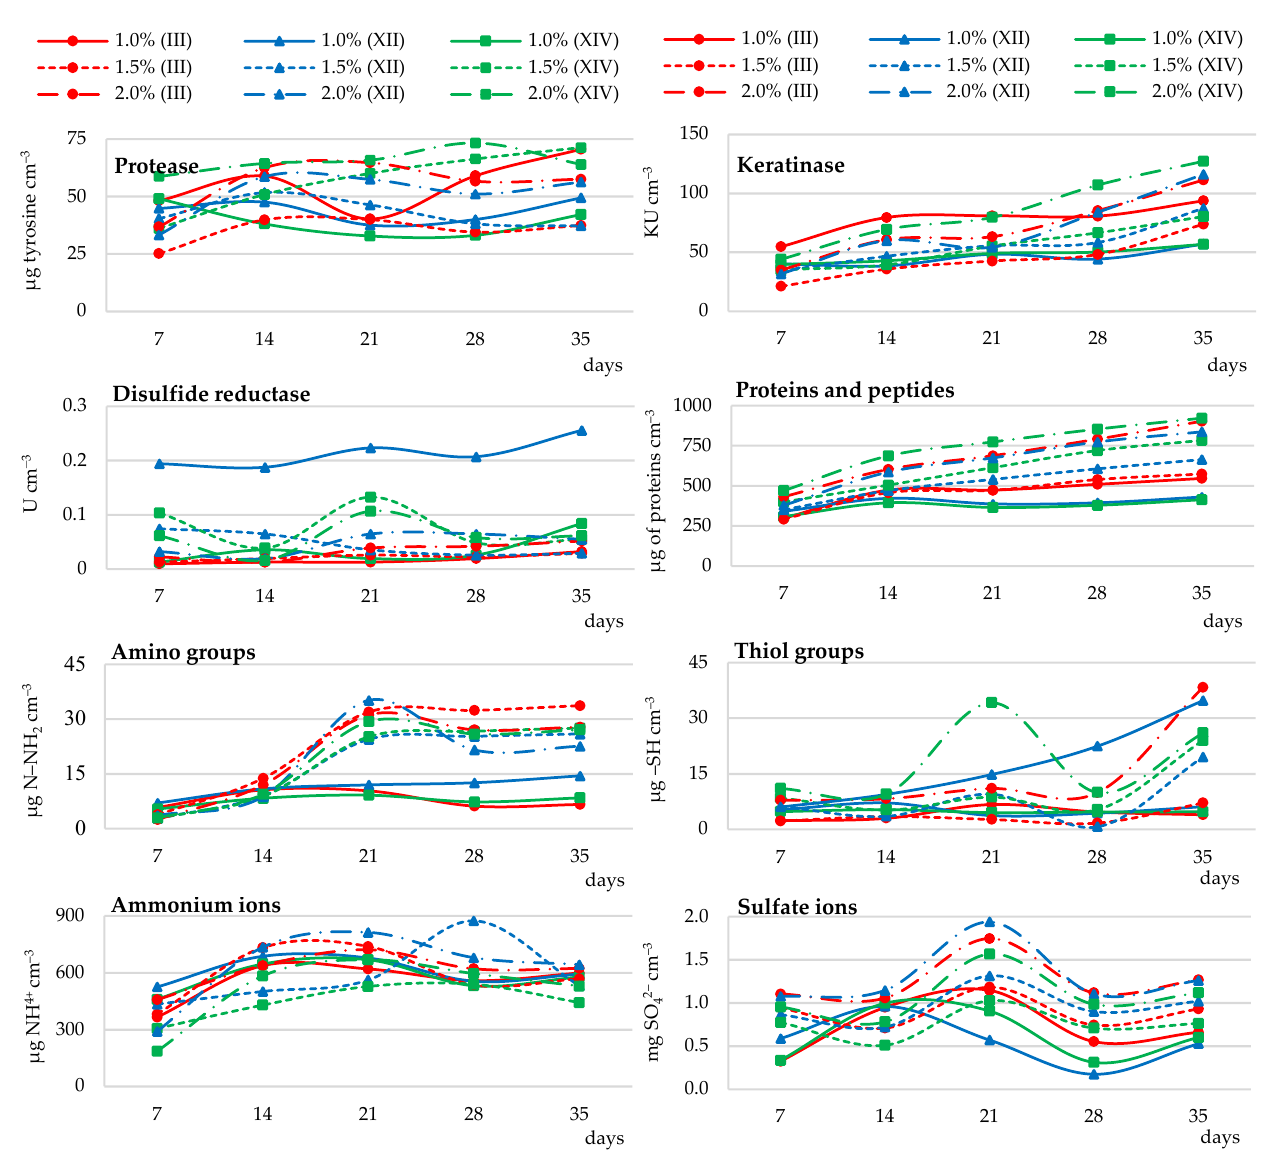
Figure 2. Dynamics of changes in enzymatic activity and released organic and mineral keratinolysis products in different concentrations of feather waste analyzed in cultures of three Trichophyton ajelloi strains III, XII, and